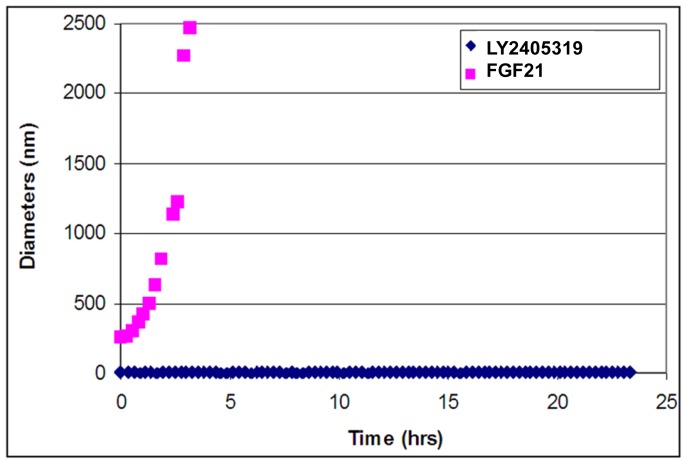
Dynamic light scattering assessment of FGF21 and LY2405319.Formulation stability of FGF21 (squares) and LY2405319 (diamonds) was assessed via dynamic light scattering at 37°C at 10 mg/mL in phosphate buffered saline at pH 7.4 containing 30 mM m-cresol. Protein concentration was 10 mg/ml.